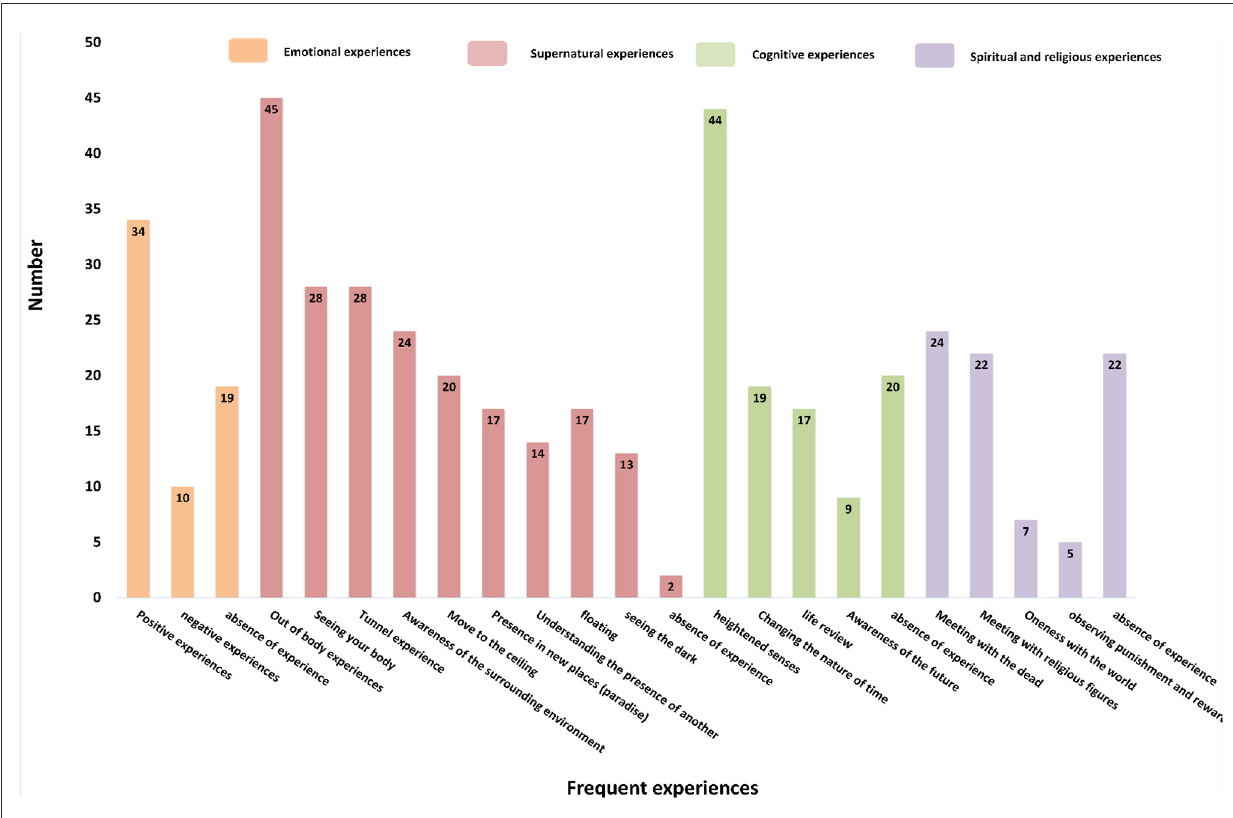
FIGURE2 Categorization of individuals who had experienced unavoidable